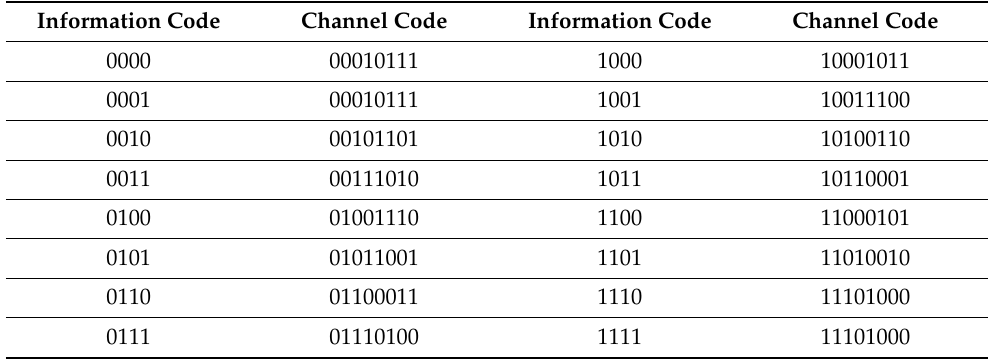
Table 1. Improved (7, 4) cyclic